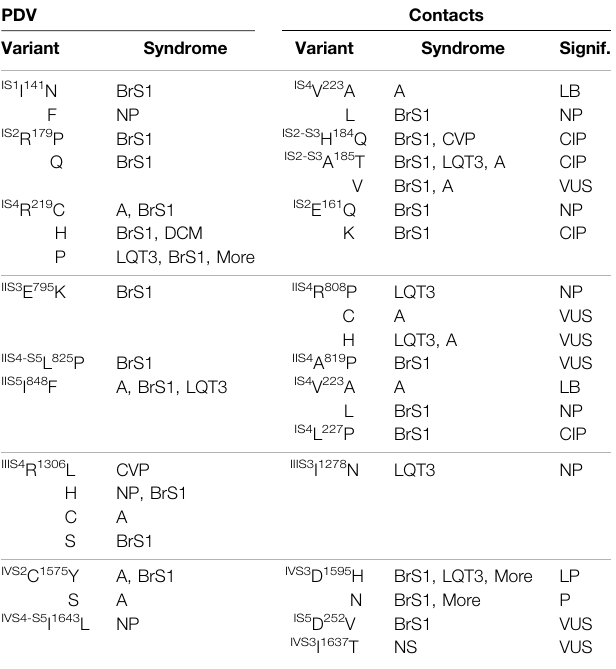
TABLE 5 | PDVs and their contacts in resting VSDs a